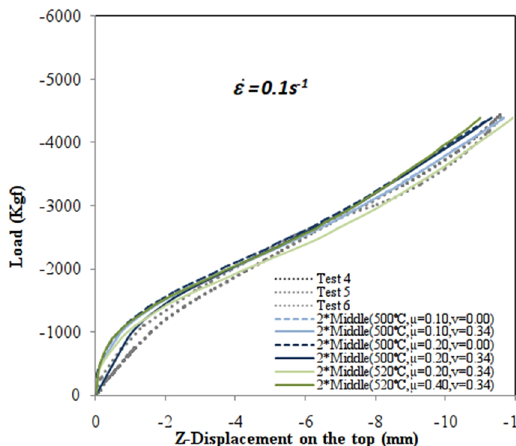
Figure 14. Load vs. Displacement for tests at 540 °C with a strain rate of 0.1 s -1 obtained from the experiments (dotted lines), and from the simulation (solid and dash lines).